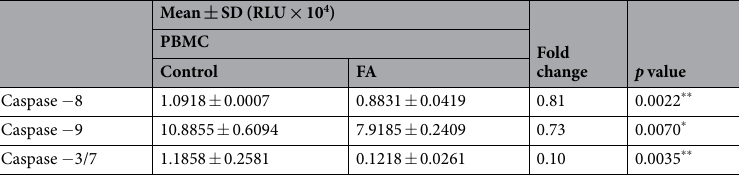
Table 1. Effect of FA on caspase ( − 8, − 9, − 3/7) activity in healthy PBMCs. SD: standard deviation; RLU: relative light units; * p < 0.05; ** p < 0.005.